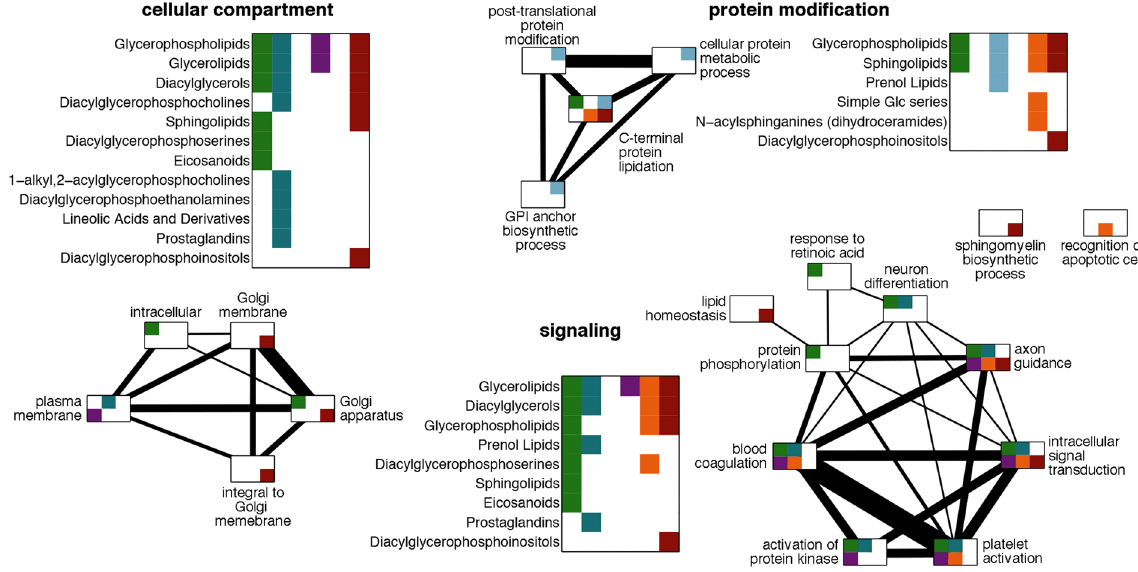
Figure 4. Functional modules. The network nodes represent GO terms significantly enriched in enzymes linked to the lipid predictors of long MLS, and having lower dN/dS values in the long-living species compared to the short-living species. The edges represent enzymes shared between terms with line width proportional to the number of shared enzymes: from 1 to 12. Colored squares within each GO term node indicate the tissue in which these enzymes are linked to the lipid predictors of long MLS: green – liver, dark blue – muscle, light blue – kidney, magenta – heart, orange – brain cortex, brown – cerebellum. Sub-classes of the lipid predictors of long MLS linked to the enzymes in each functional group are listed next to the corresponding network module. The colors indicate the tissues where they are used as predictors of long MLS, according to the same color code as the GO